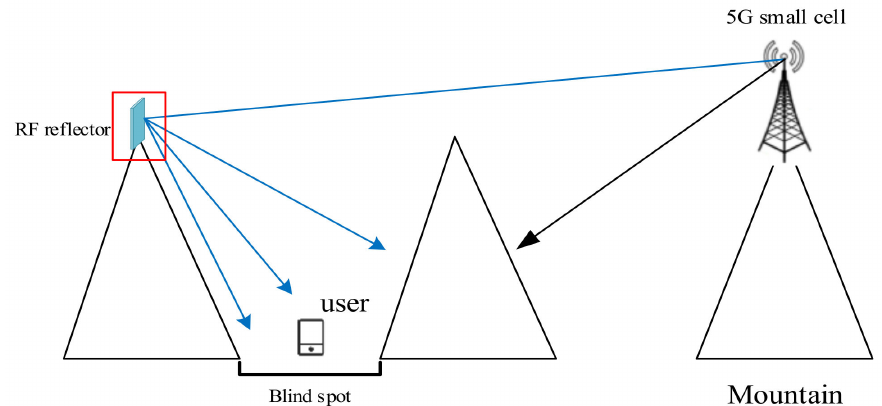
Figure 2. Using dual antenna system to solve the signal coverage of blind area in complex